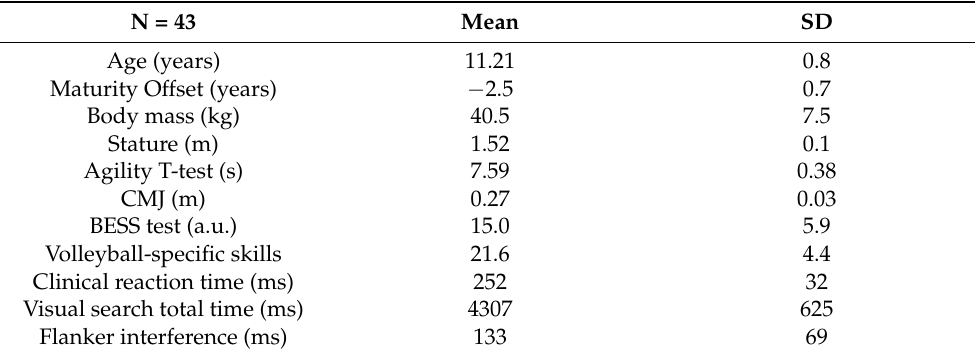
Table 1. Descriptive statistics for anthropometric, motor, and cognitive